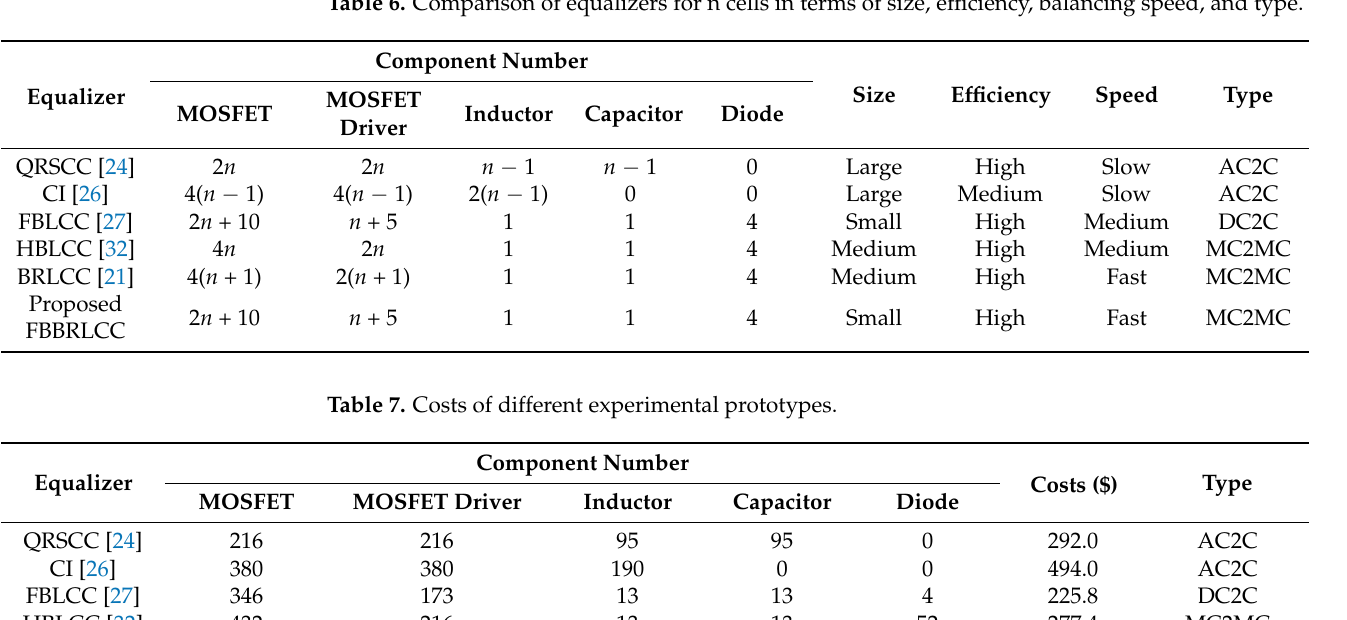
Table 6. Comparison of equalizers for n cells in terms of size, efficiency, balancing speed, and type.